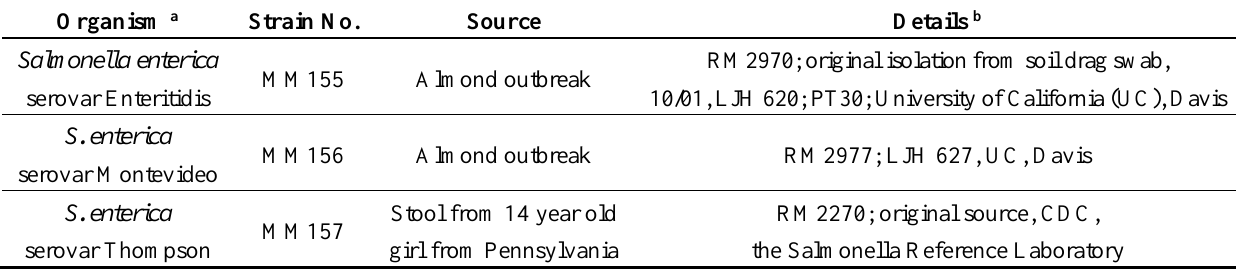
Table 2. Salmonella